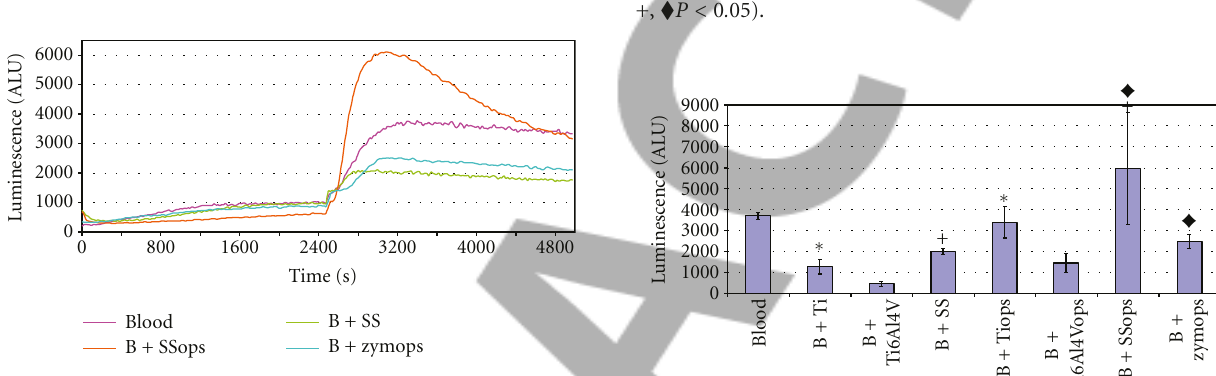
Figure 3: Chemiluminescence response of whole blood cells to SS, opsonised and nonopsonised, and opsonised zymosan (positive control). Reaction mixture included whole blood cells without particulate materials (negative control) and in the presence of SS, SSops, and Zymops particles. Cells were stimulated with fMLP+PMA at 2400 s.